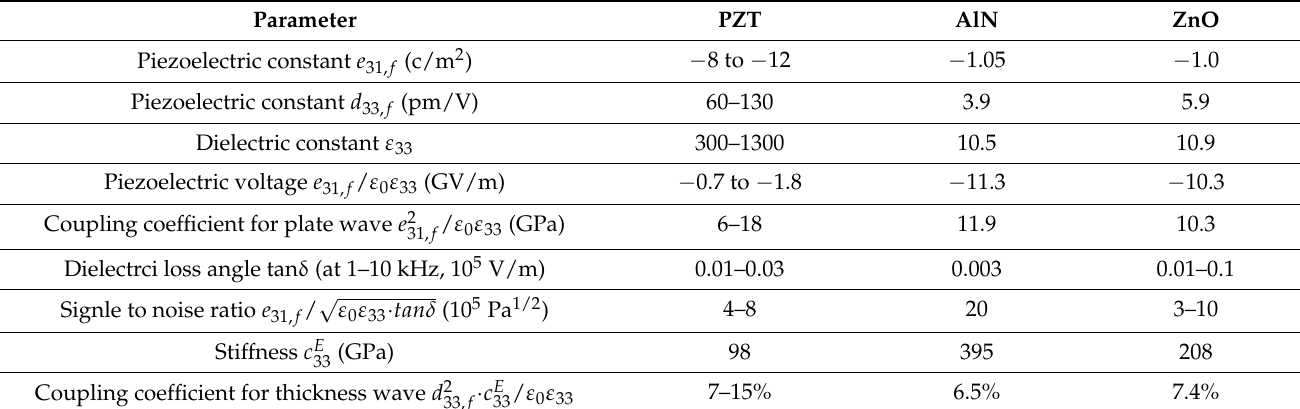
Table 2. Comparison of PZT, AlN and ZnO thin film